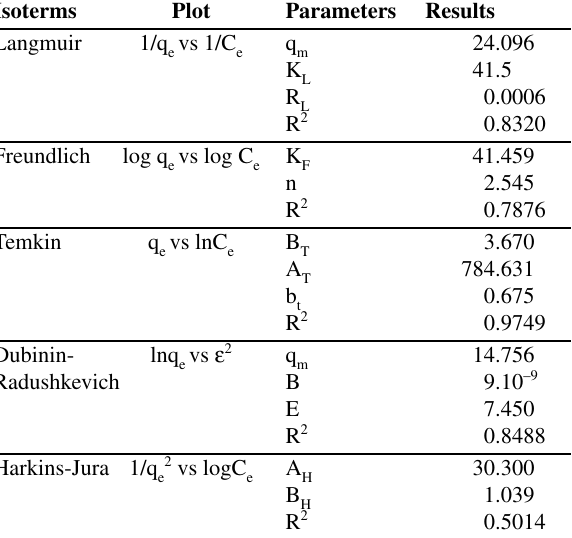
Table 1. Isotherm parameters for the adsorption of borax waste